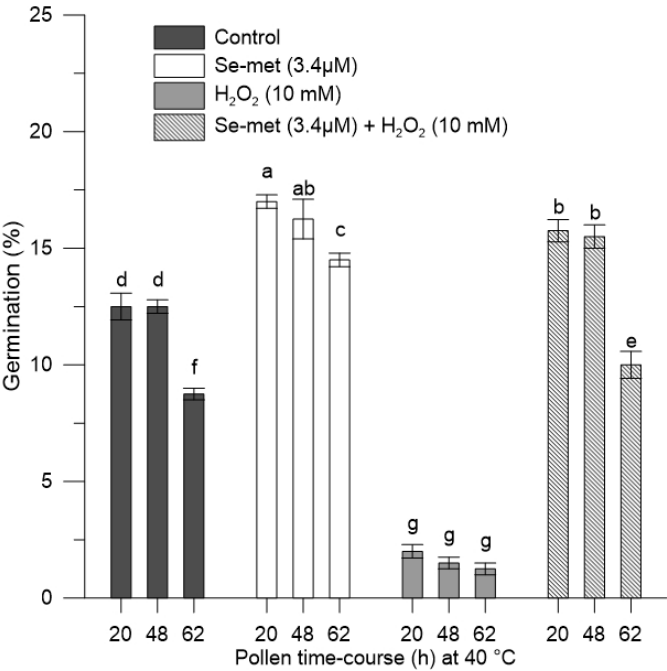
Figure 5. Germination of olive pollen incubated at 40 ◦ C for 20, 48, and 62 h. Pollen was untreated (control) or treated with H 2 O 2 (10 mM), Se-met (3.4 µM), and Se-met (3.4 µM) + H 2 O 2 (10 mM). Values are expressed as means ± SEM. Different letters indicate statistically significant differences ( p < 0.05).